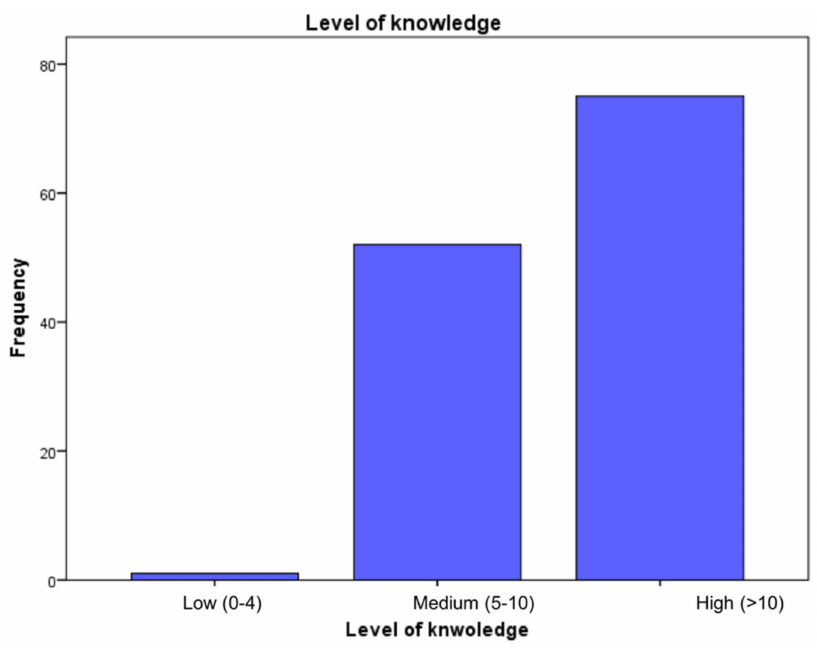
Figure 2. Level of knowledge among overall participants measured by the number of correct answers out of 14 questions ( n =